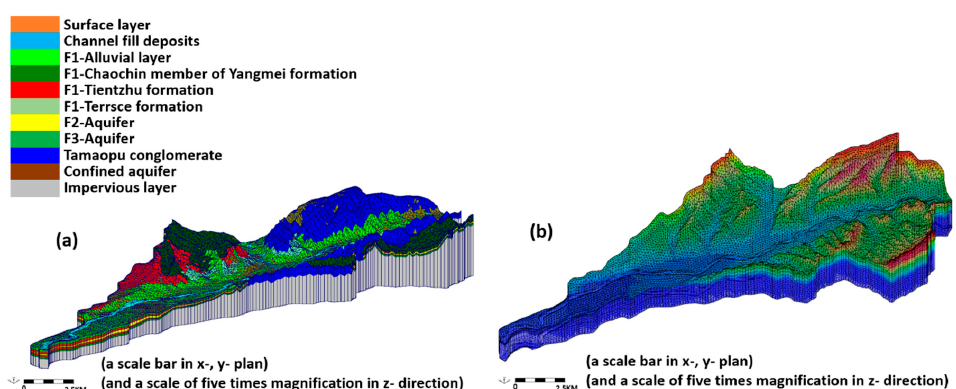
Figure 4. ( a ) Hydrogeological classification of the Fengshan Creek basin and ( b ) mesh configuration in WASH123D (redrawn from Wu and Shih, 2018).